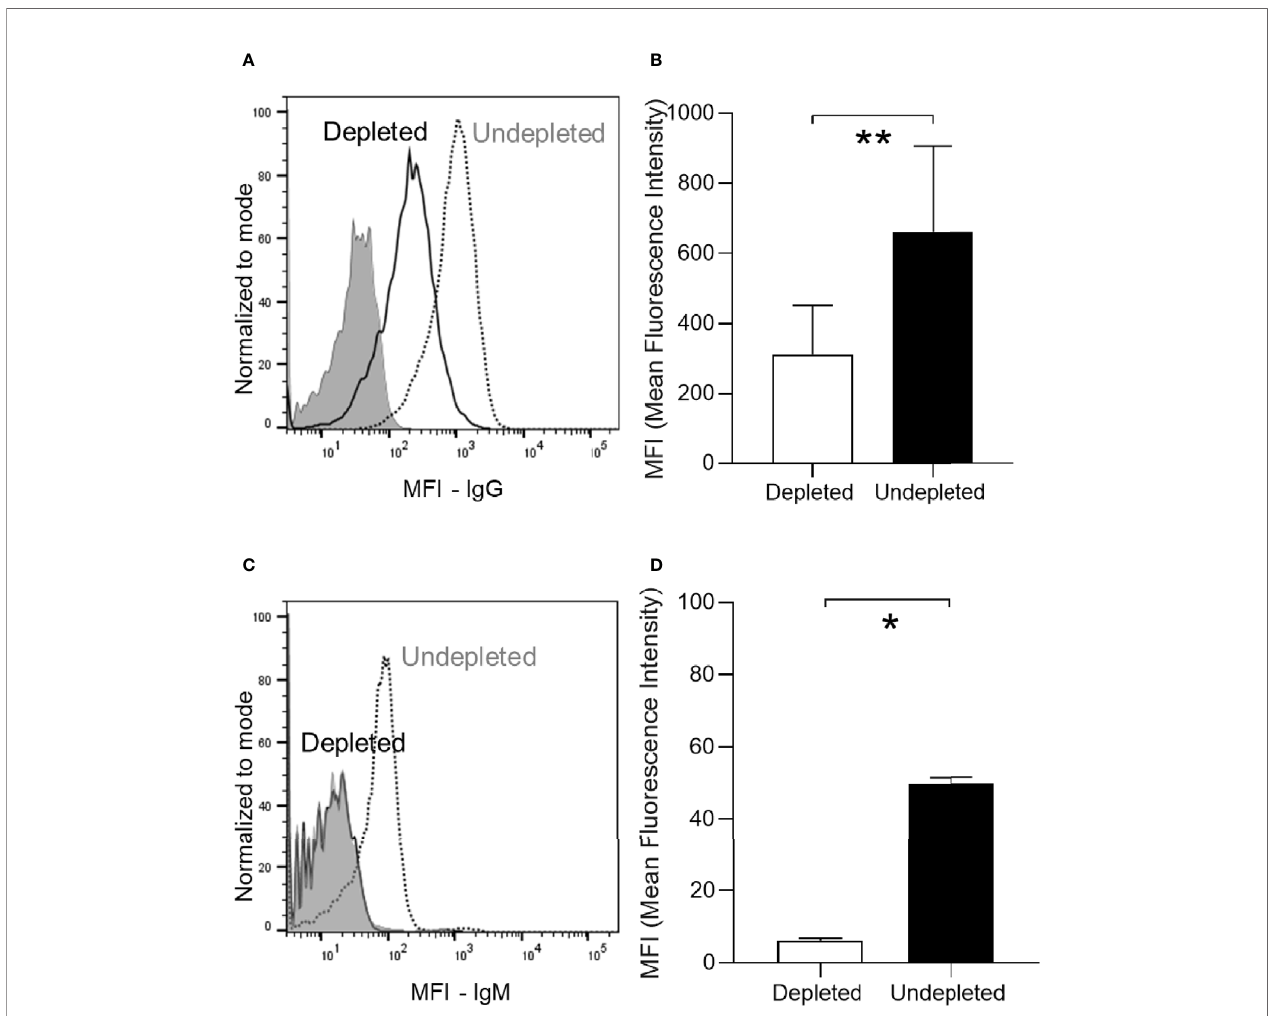
FIGURE 5 | Antibody response in depleted/colonized mice. (A) Anti-pneumococcus (6B strain) speci fi c IgG level has been measured by serum deposition assay in individual mice as shown by a representative FACS histogram plot. The dotted line represents the undepleted/colonized, the solid line the depleted/colonized and gray fi lled line the non-colonized control sample. (B) The average MFI for each group are also reported in panel (B) . (C, D) Anti-pneumococcus (6B strain) IgM have been also measured by serum deposition assay on pooled sera of each group. Bars represent the average values for each group. Error bars indicate standard deviations and Mann Whitney U test has been used for statistical analysis (*P < 0.05, **P <